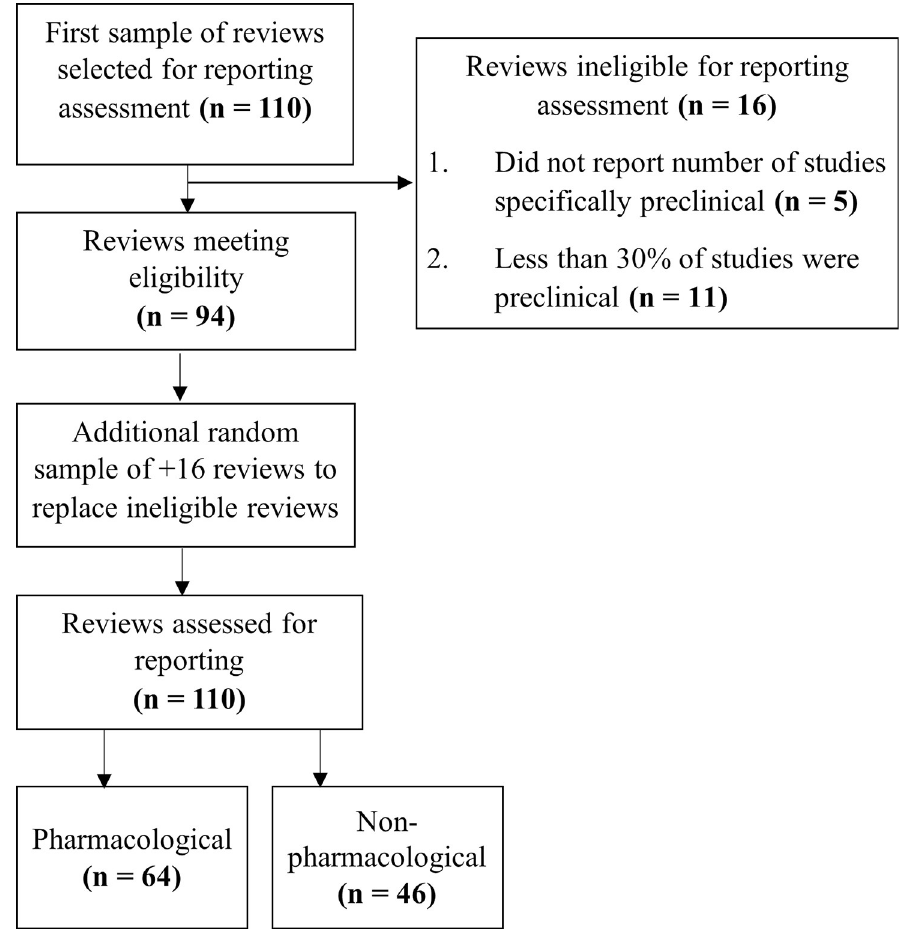
Fig 4. Flowchart of reviews selected for the reporting